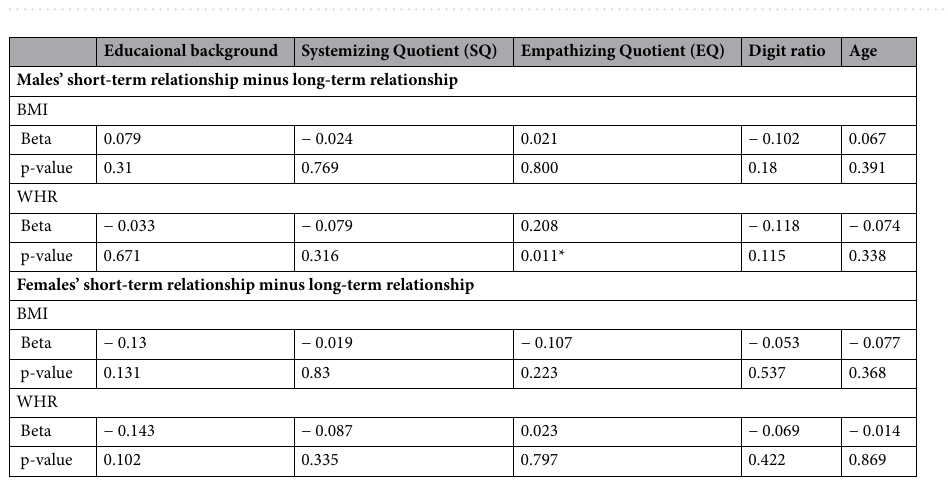
Figure 2. Histograms of differences of BMI and WHR between short-term and long-term relationships for male participants ( A ) and female participants ( B ). BMI Diff and WHR Diff in x and y axes indicate the selected BMI and WHR in a short-term relationship minus the same in a long-term relationship for each participant.